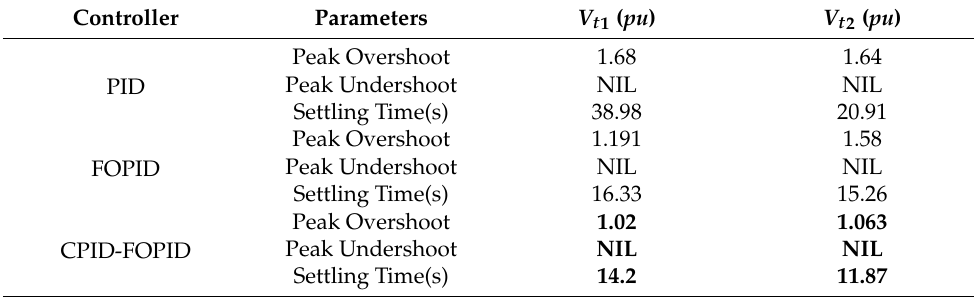
Table 6. Numerical values of T s ( s ), M P , and U P for AVR.